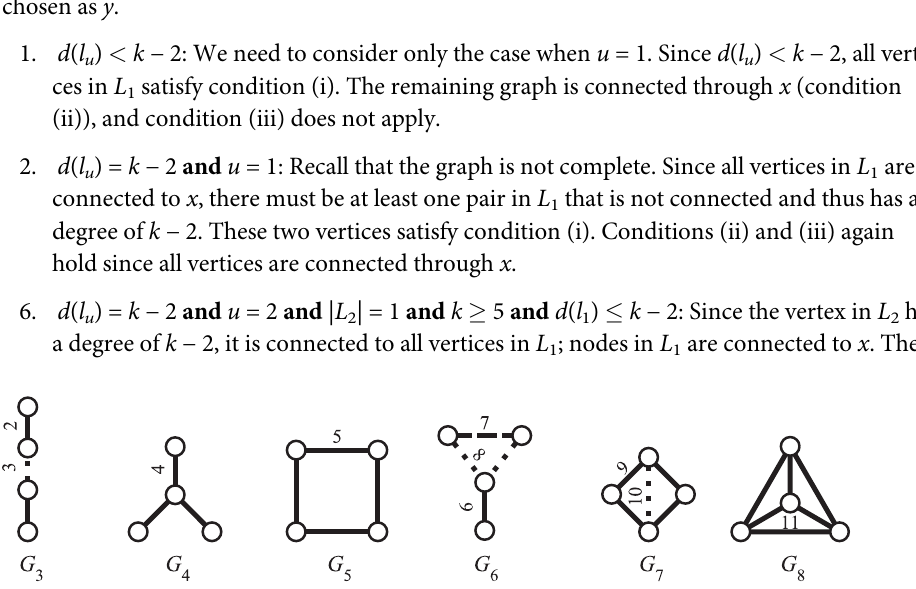
Fig 8. Edge orbits in four-node graphlets. Different styles of lines within a graphletindicateedge